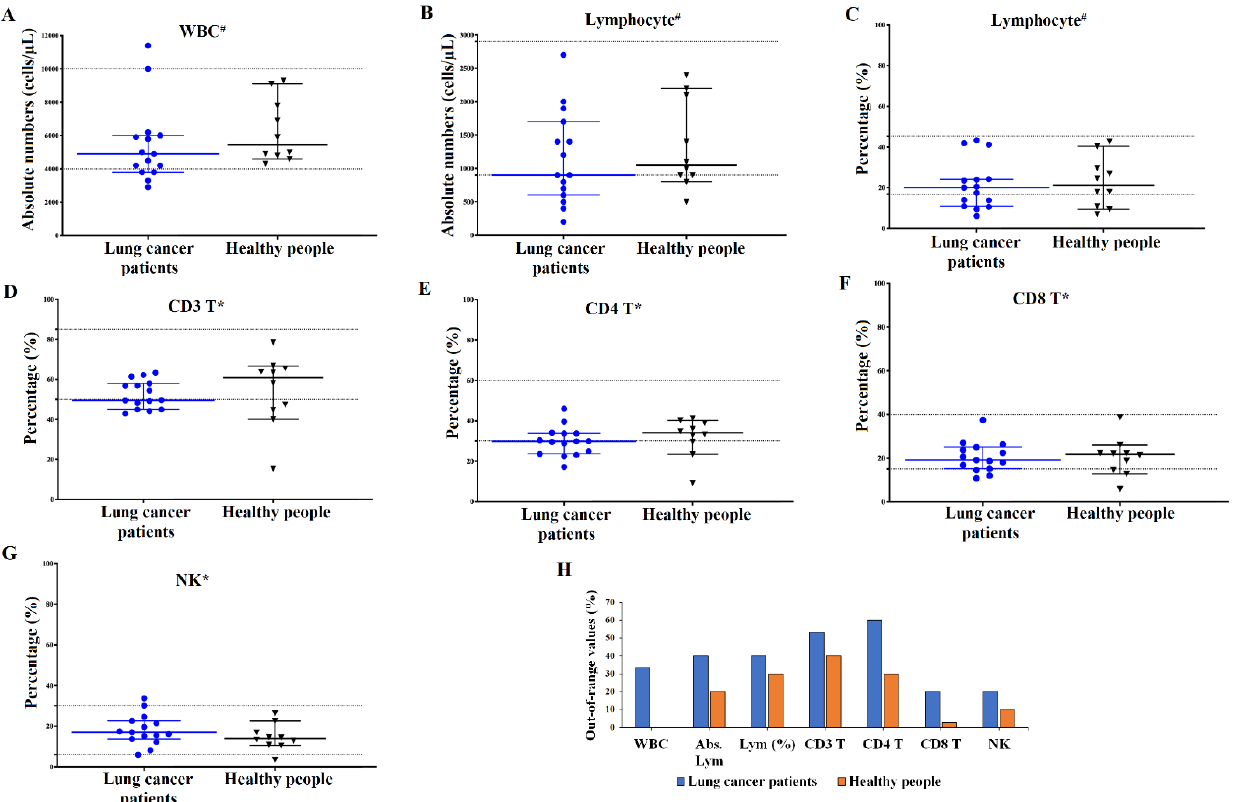
Figure 1. The peripheral blood indices of cancer patients (n = 15) and healthy people (n = 10). The complete PB cells were counted on the hematology analyzer and flow cytometry system. Each data point represents one patient, blue and black lines indicate the median of lung cancer and healthy samples, respectively, and dotted lines indicate the upper and lower limits of reference intervals. ( A ) The absolute numbers of WBCs (cells/ µ L). ( B ) The absolute numbers of lymphocytes in PB (cells/ µ L). ( C ) The percentage of peripheral blood lymphocytes (%) among white blood